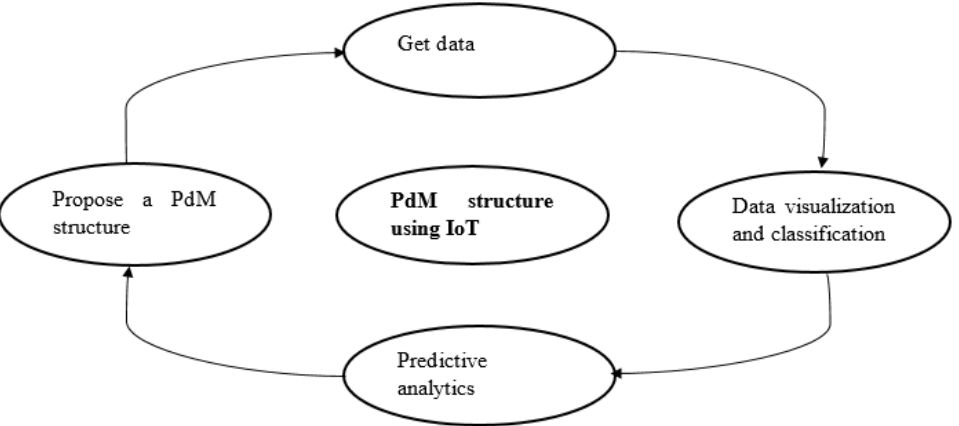
Figure 2. Methodological steps to construct a Predictive Maintenance (PdM) Structure using Internet of Things